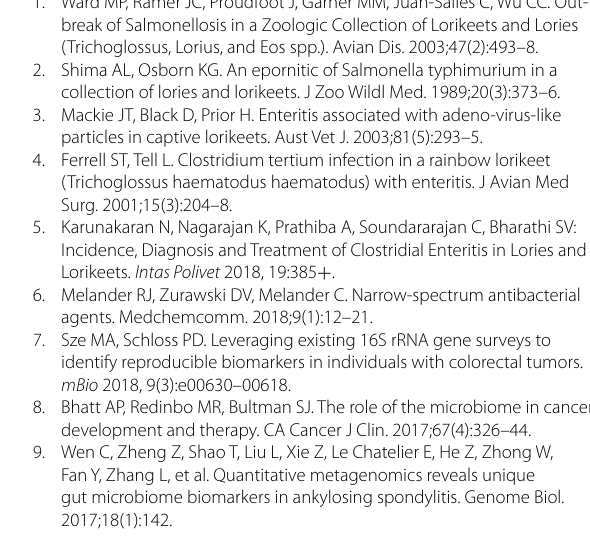
table preparation. WC, KS, and YV were involved in trypsin inhibitor testing and data interpretation. WC and YV were also involved manuscript writing and figure preparation. All authors read and approved the final